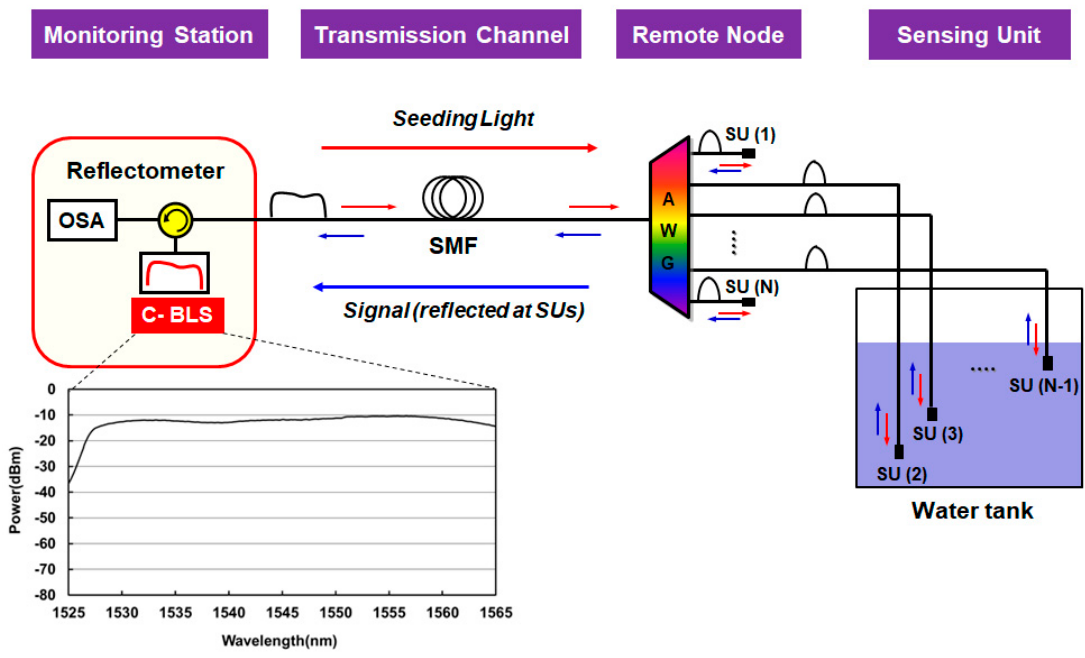
Figure 7. Schematic diagram of the dense wavelength division multiplexing (DWDM)-based water level monitoring system. Adapted from Lee et al. [42].